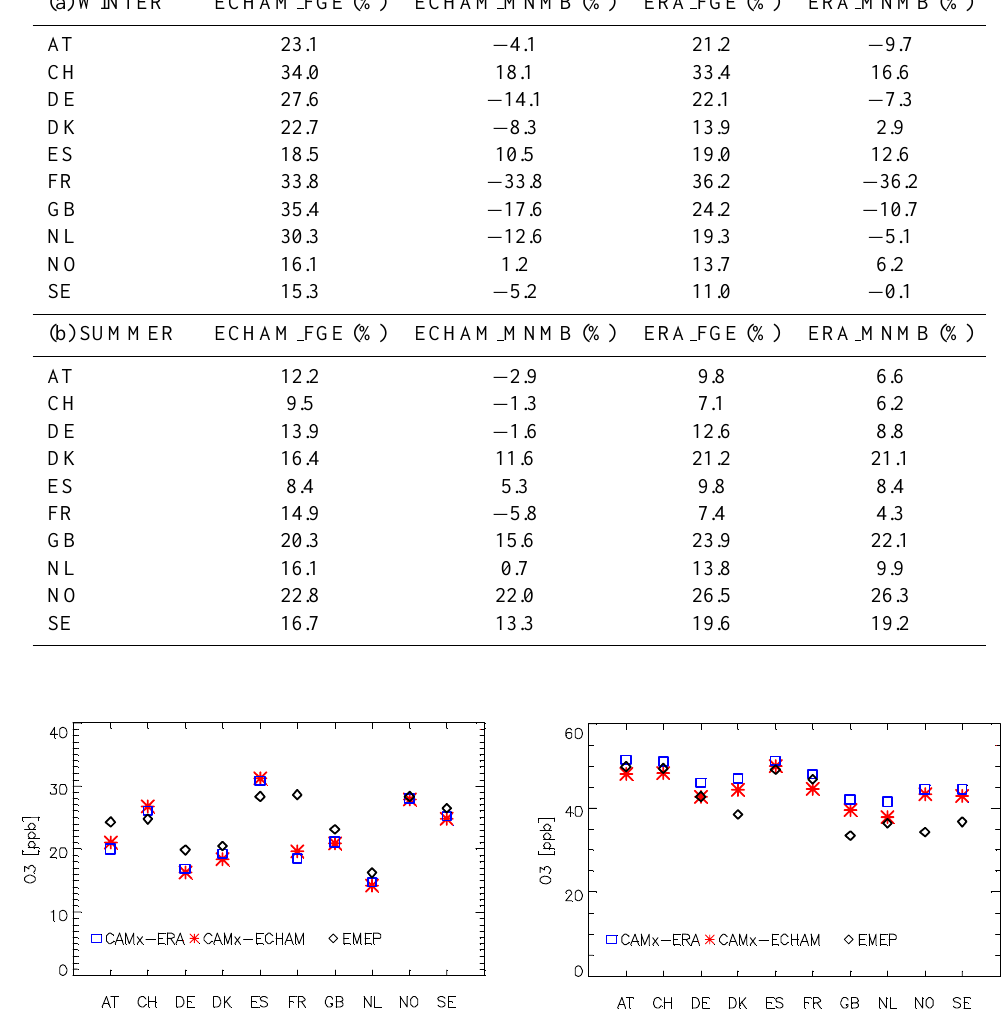
Fig. 1. Average decadal (1991–2000) surface daytime (08:00–16:00UTC) ozone concentrations for different European counties, for winter (DJF) and summer (JJA) (left and right panels respectively). Depicted are ozone measured and simulated concentrations for both CAMx ERA and ECHAM runs. Country codes: Austria (AT), Switzerland (CH), Germany (DE), Denmark (DK), Spain (ES), France (FR), Great Britain (GB), the Netherlands, Norway (NO) and Sweden (SE).